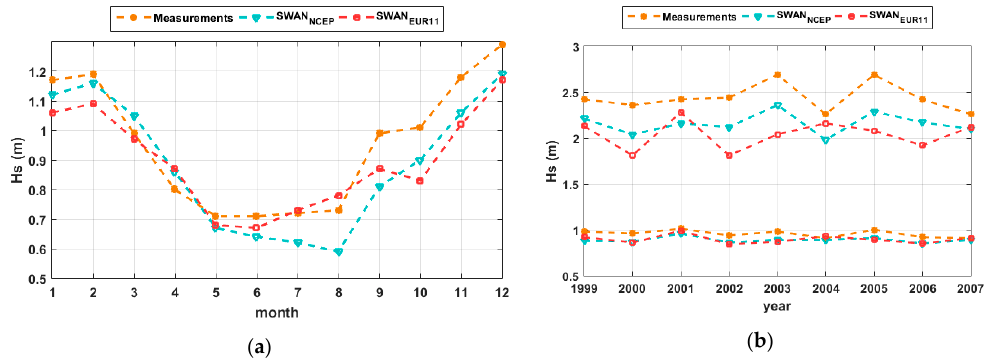
Figure 11. Comparison between Hs measured at Gloria platform and the simulated values from SWAN EUR11 and SWAN NCEP at the same location, time interval 1999–2007: ( a ) Monthly means; and, ( b ) Annual means (dashed lines) and 95th percentile (solid